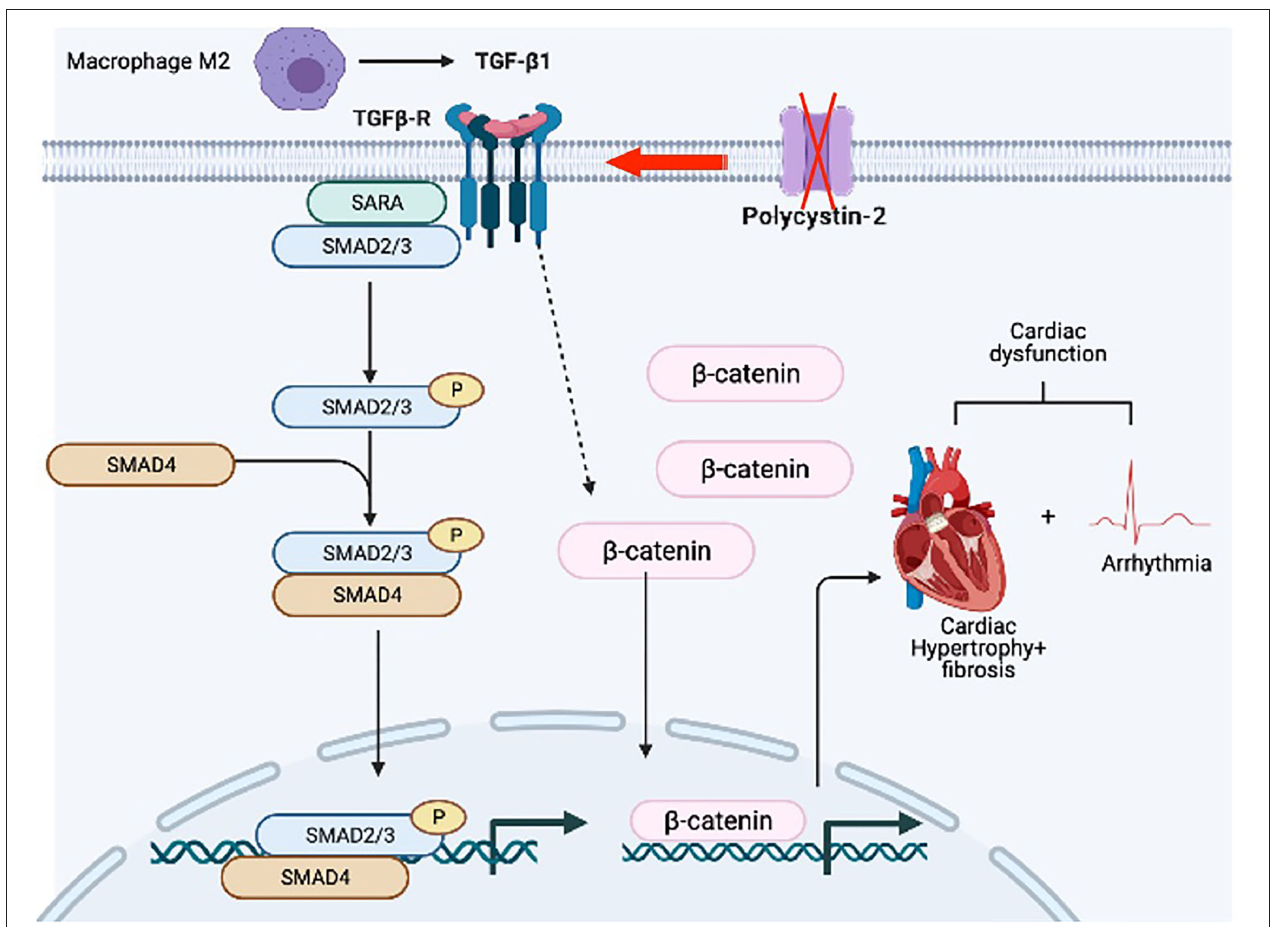
FIGURE 11 | Hypothetical diagram summarizes the pathogeneses of PKD hearts. We hypothesize that hearts from Pkd2 -KO mice are characterized by the overexpression of TGF- β 1 receptor. Local TGF- β 1 secretion by infiltrating macrophages further exacerbates the activation of fibrotic pathways resulting in hypertrophy and interstitial fibrosis. Subsequent activation of TGF- β 1 receptor results in the activation of pSMAD3 and b-catenin in the myocytes. The fibrosis in the sinoatrial node and surrounding tissue can results in arrhythmogenic heart. All of which will cause systolic and diastolic cardiac dysfunction.